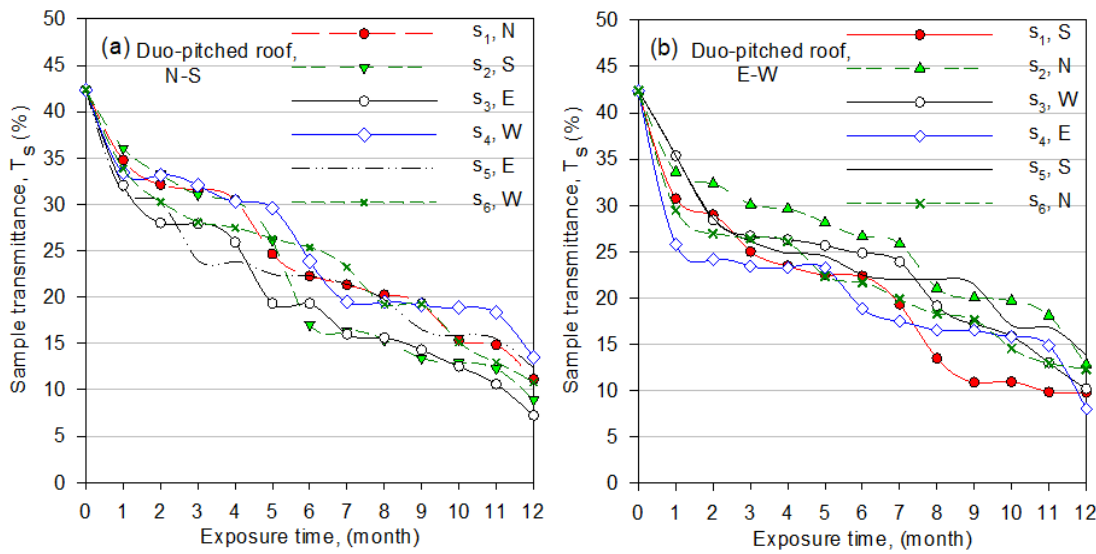
Figure 4. Degradation of the sample transmittances ( T s ) with the exposure time for the duo-pitched prototype, oriented in the N–S ( a ) and E–W ( b ) directions under arid climatic conditions.